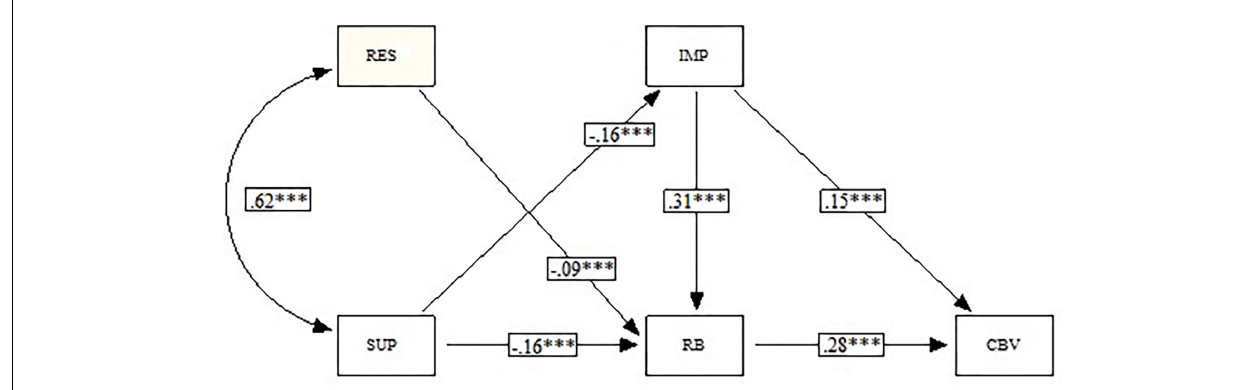
FIGURE 2 | Post hoc path model (RES, restriction; SUP, supervision; IMP, impulsivity; RB, risk behaviors; CBV, cyber-victimization). ∗∗∗ p < 0.001.